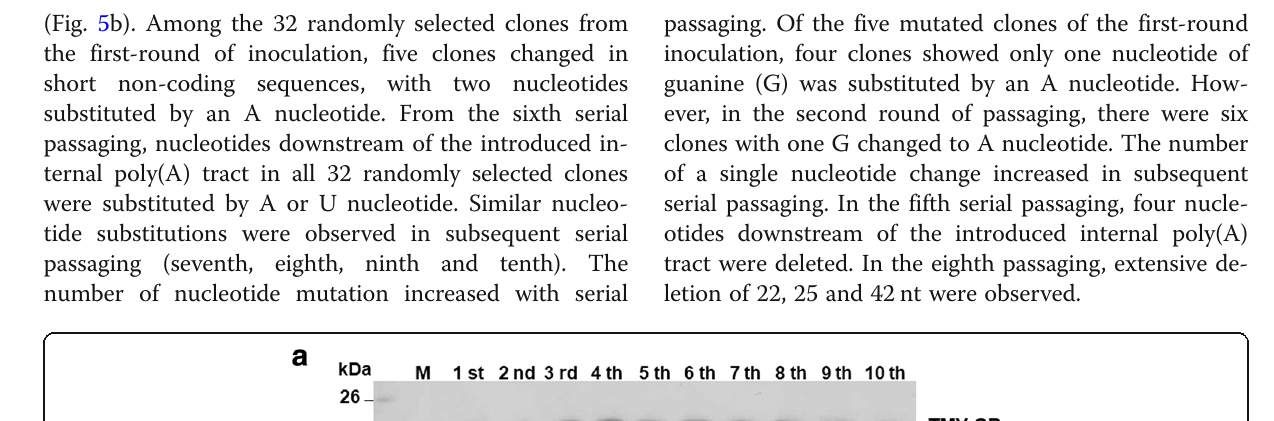
Fig. 2 Symptoms of TMV (24A + UPD) inoculated N. benthamiana plants during 10 rounds of serial passaging of TMV (24A + UPD) at 5 dpi and 11 dpi, respectively